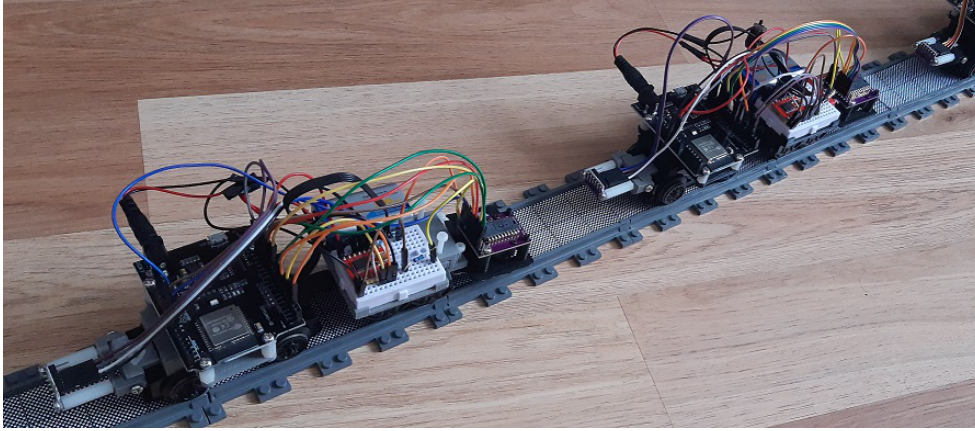
Figure 9. Block diagram of a single agent. Every agent is composed of the same modules and sensors.